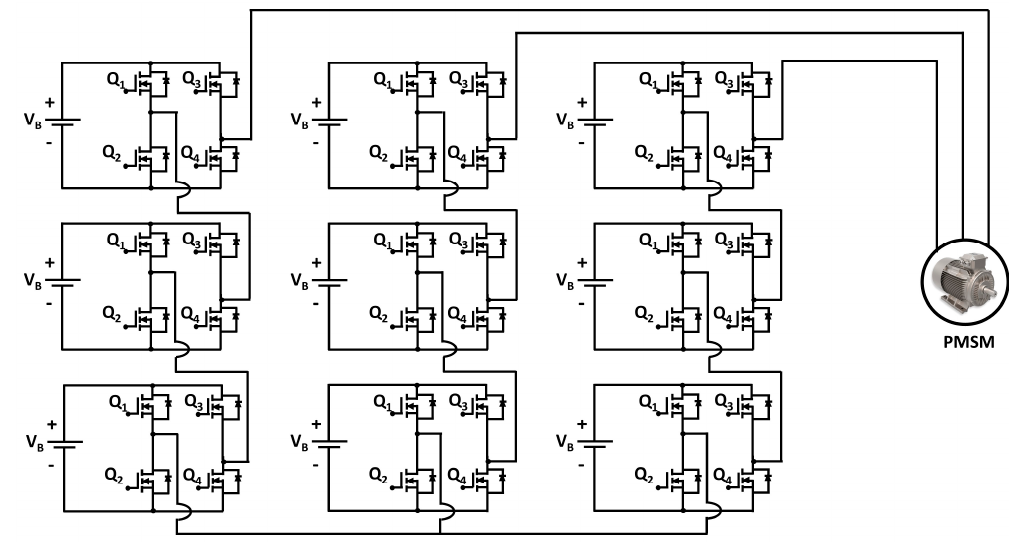
Figure 31. Topology of a 7-level multilevel inverter (MLI) [243,244].